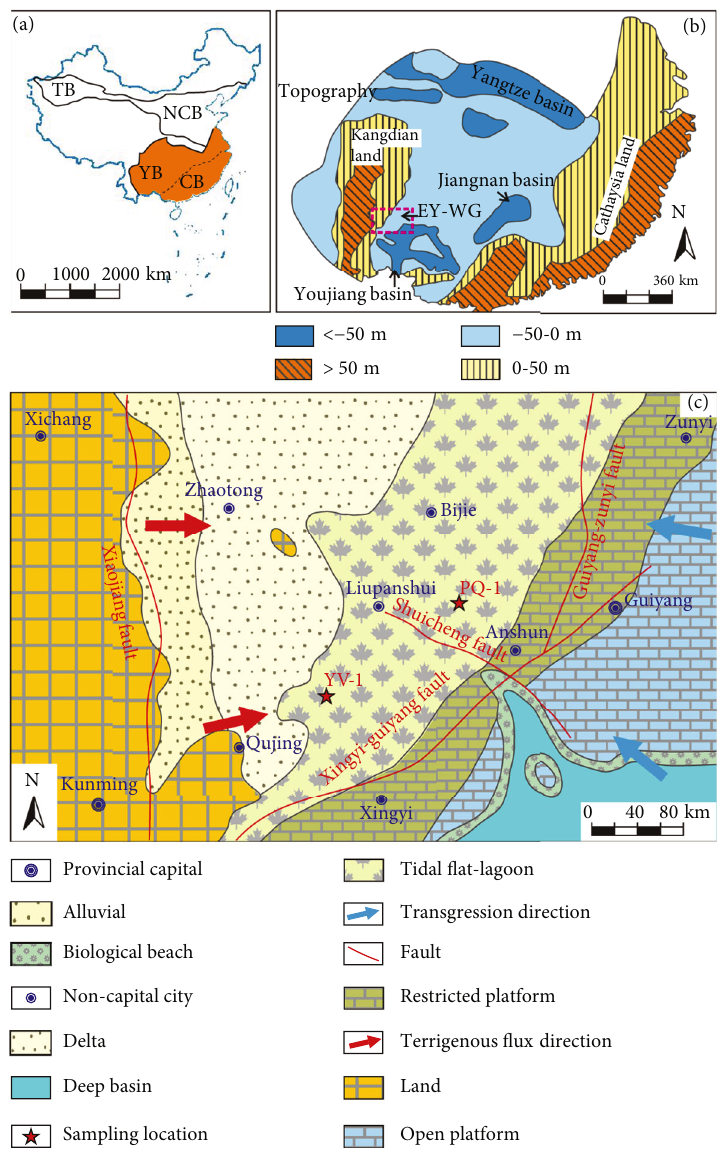
Figure 1: (a) Location of the South China block. (b) Tectonic characteristics of the South China block and the location of eastern Yunnan- western Guizhou area (based on [31, 40]). (c) Lithofacies paleogeography of eastern Yunnan-western Guizhou area (EY-WG) in the Late Permian (modi fi ed from [25, 26]) showing the sampling position of this study. TB: Tarim block; NCB: North China block; YB: Yangtze block; CB: Cathysia